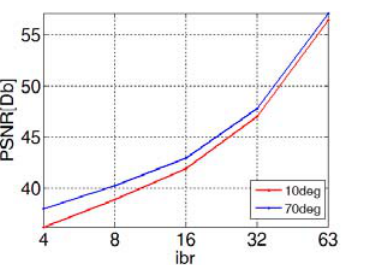
Figure 4: PSNR values as a function of ibr for 10° and 70° illumination angles